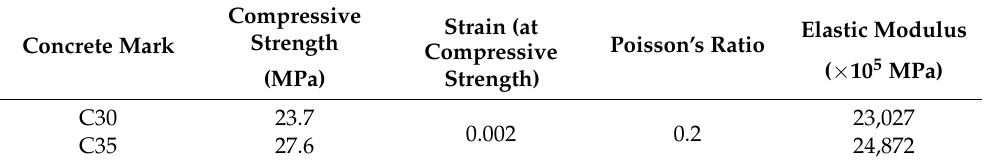
Table 2. Concrete properties.